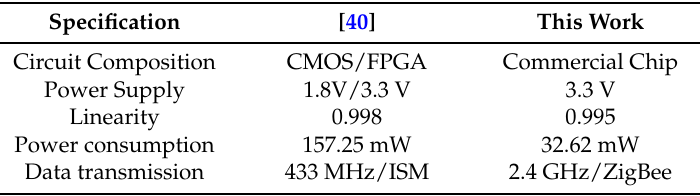
Table 5. Comparison between our system and previous